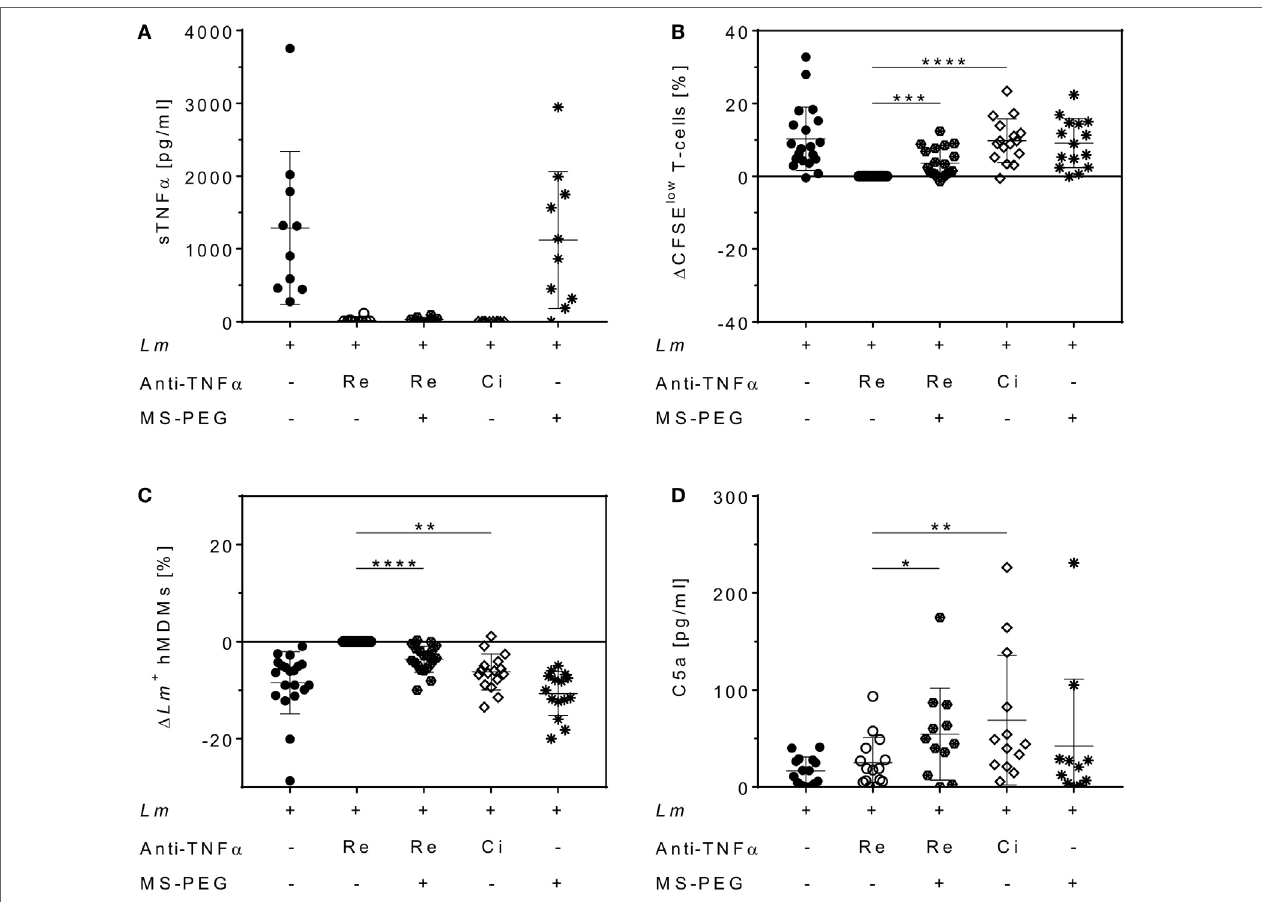
FigUre 7 | Increased T-cell proliferation and reduced Leishmania major ( Lm ) infection rates in human monocyte-derived macrophages (hMDMs) after PEGylation of Remicade ® . The Lm -infected hMDM/peripheral blood lymphocyte co-culture ( ● ) was treated with Remicade ® ( ○ ), PEGylated Remicade ® ( ), Cimzia ® ( ◊ ), and MS-polyethylene glycol (PEG) (  ). 7 days after infection, soluble TNF α (sTNF α ) neutralization (a) or C5a levels (D) were measured by ELISA, and T-cell proliferation (B) as well as the percentage of Lm -infected hMDMs (c) were determined by flow cytometry. (B,c) T-cell proliferation and infection rates are presented as differences to the untreated control of the same donor. At least four independent experiments were conducted of which data are shown as mean ± SD ( n ≥ 10). The Wilcoxon signed-rank test was performed to evaluate statistical significance. * P < 0.05; ** P < 0.01; *** P < 0.001; **** P <